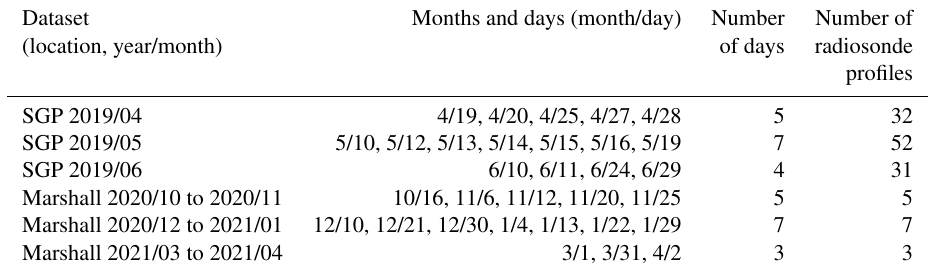
Table 4. The first column shows the names of the datasets used in the experiments. The second column lists the specific dates that are included in each dataset. The third and fourth columns list the number of days in each dataset and the total number of coincident RS profiles.